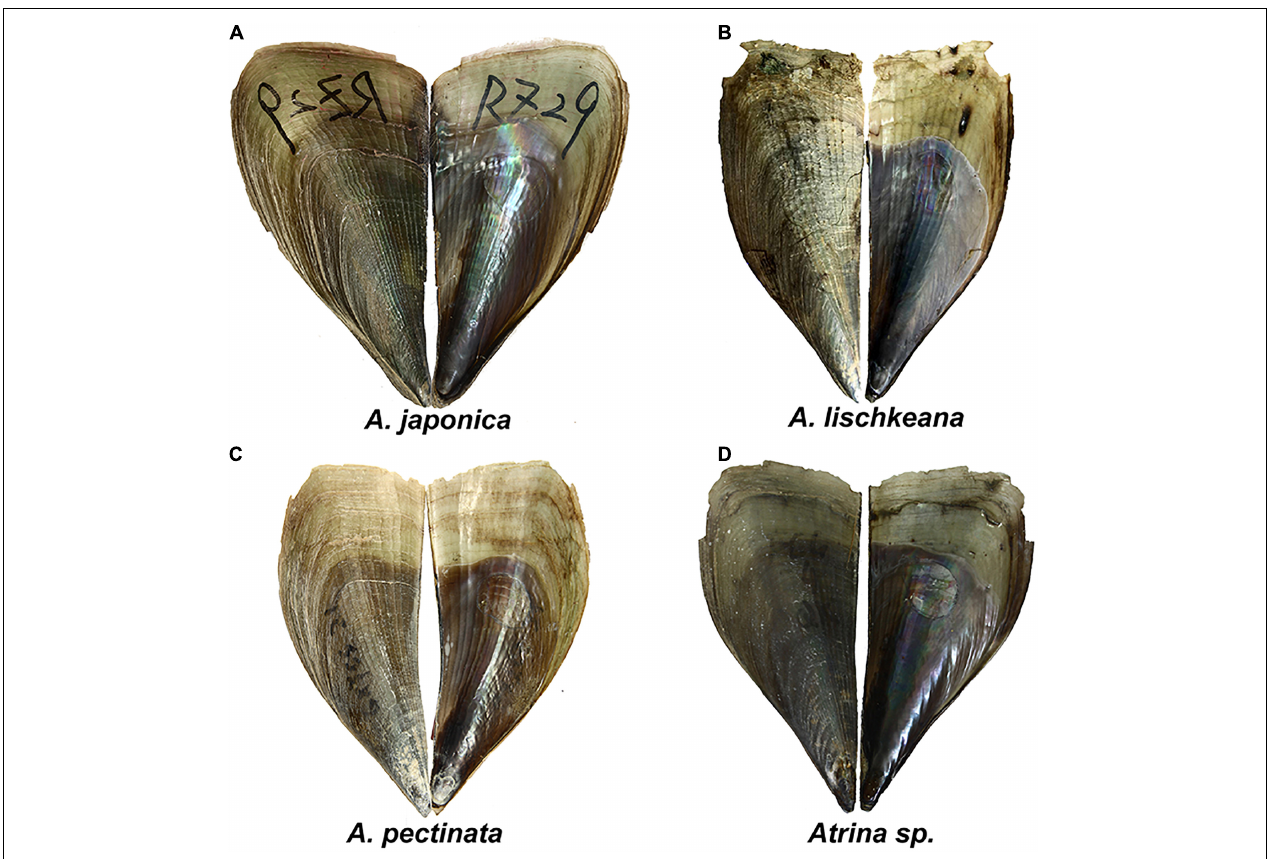
FIGURE 2 | Shell morphology of (A) A. japonica , (B) A. lischkeana , (C) A. pectinata, and (D) Atrina sp. Scale bar = 20